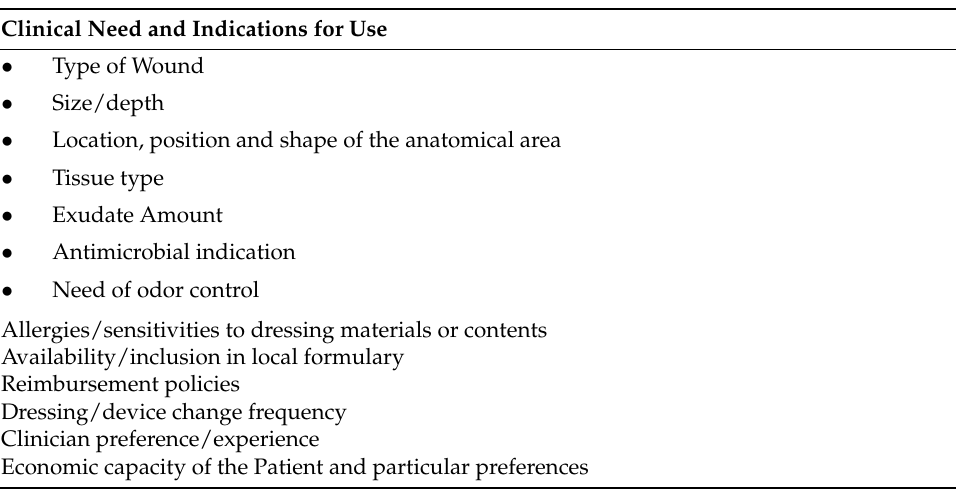
Table 4. Key factors affecting dressing/device choice. Adapted from